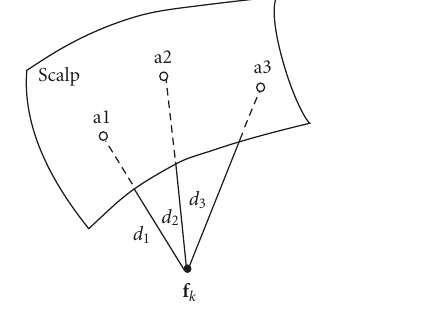
Figure 2: Part of the scalp including the electrode locations, a1, a2, and a3, and the location of the source k , f k , to be identified.